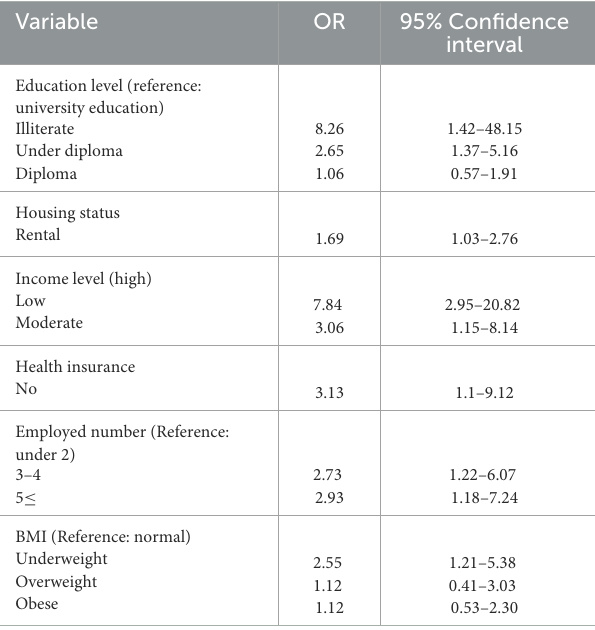
TABLE3 Adjustedlogistic regressionforfactors relatedto